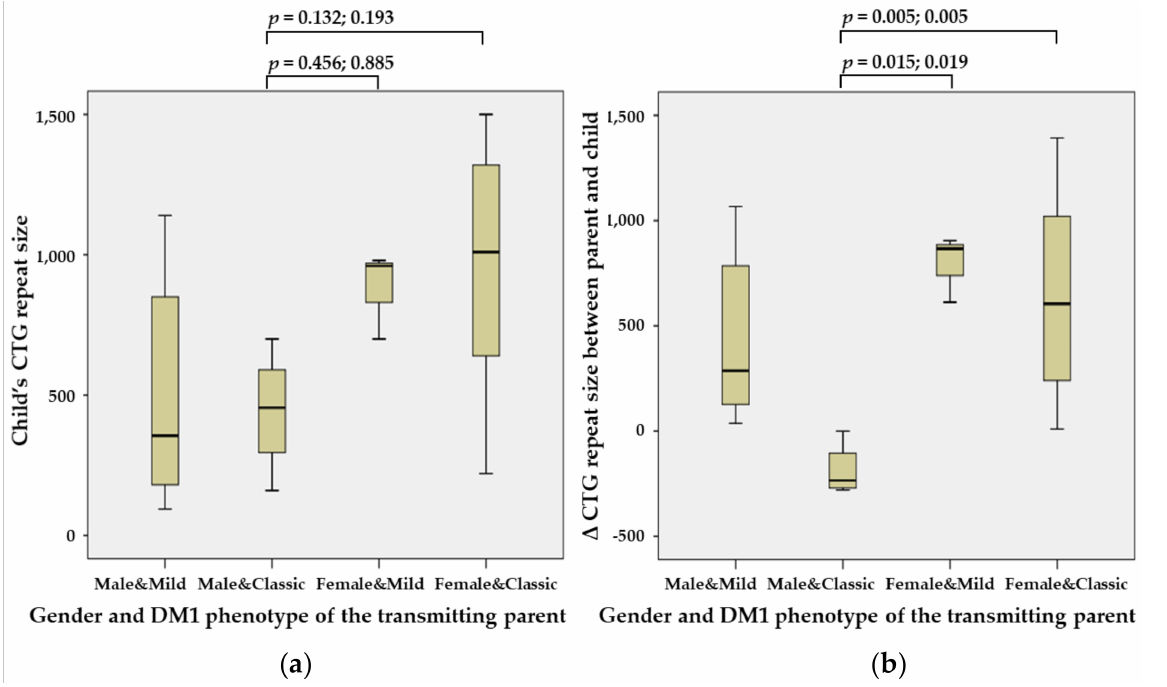
Figure 3. Intergenerational influence of the gender and DM1 phenotype of the transmitting